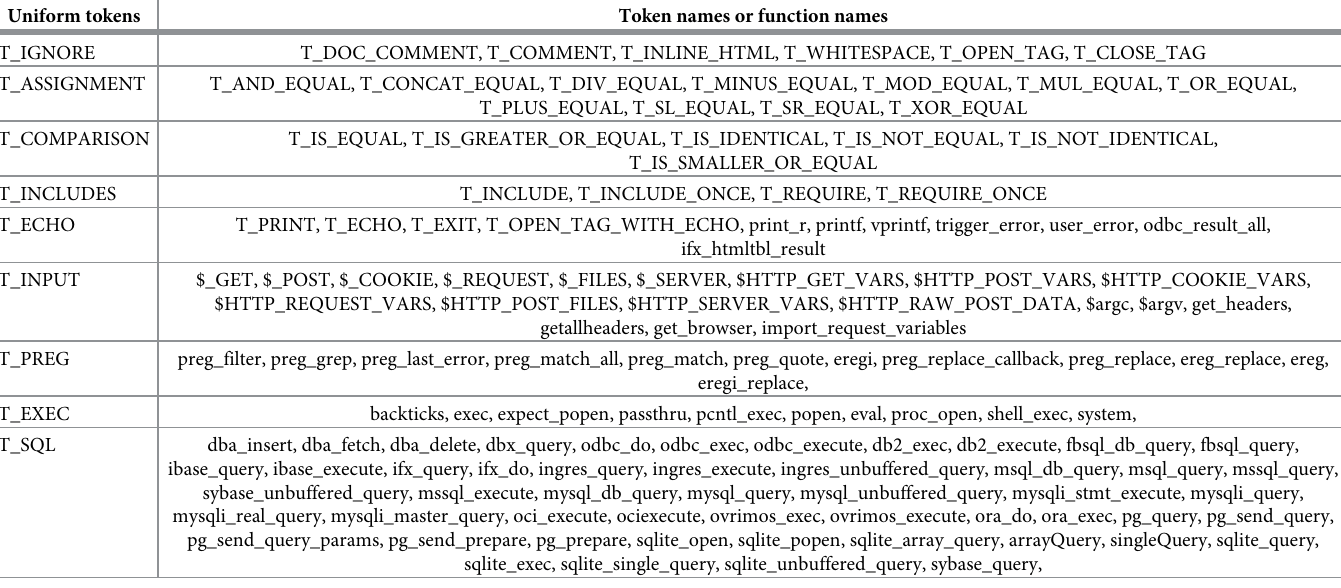
Table 1. List of uniform